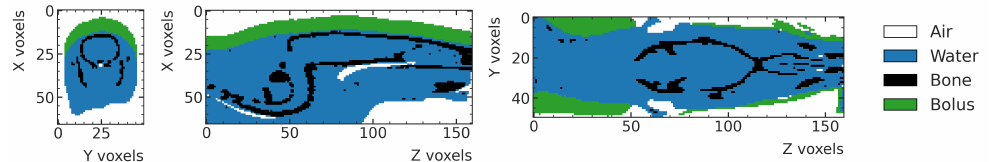
Figure 2. Example of digital rat phantom obtained from the segmentation of CT scans. Defined materials (air, water and bone) are assigned to individual voxels. Green voxels are associated to the bolus, modeled as